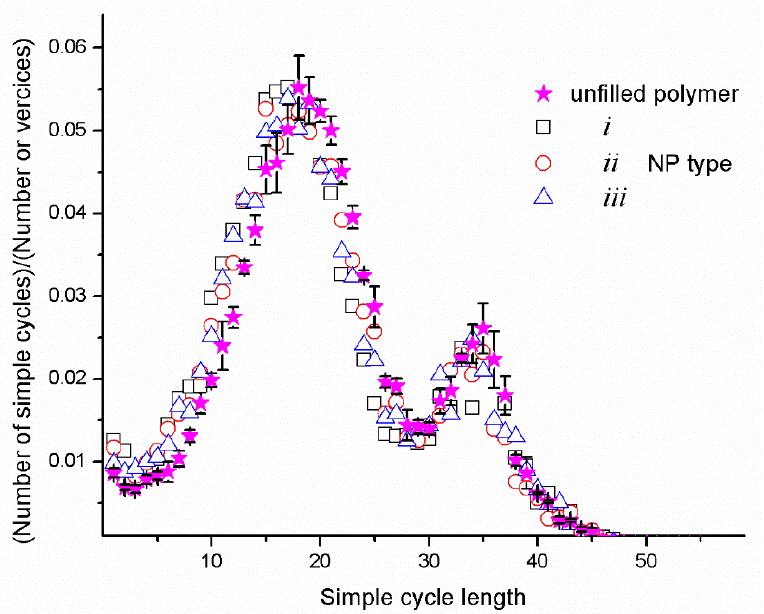
Figure 3. The normalized distributions of the length of the simple cycles for the unfilled network and networks containing nanoparticles of i , ii , and iii types ( RGC = 0).